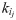
SuperVec model: NN1 and NN2 architectures are shallow neural networks with respectively the CBOW and the Skip-gram variant of the Word2Vec model.The context of kij comprises its nearby words and is denoted kij-w,….,kij-1, kij+1....kij+w. The context of the si are sequences which have the same label as si.